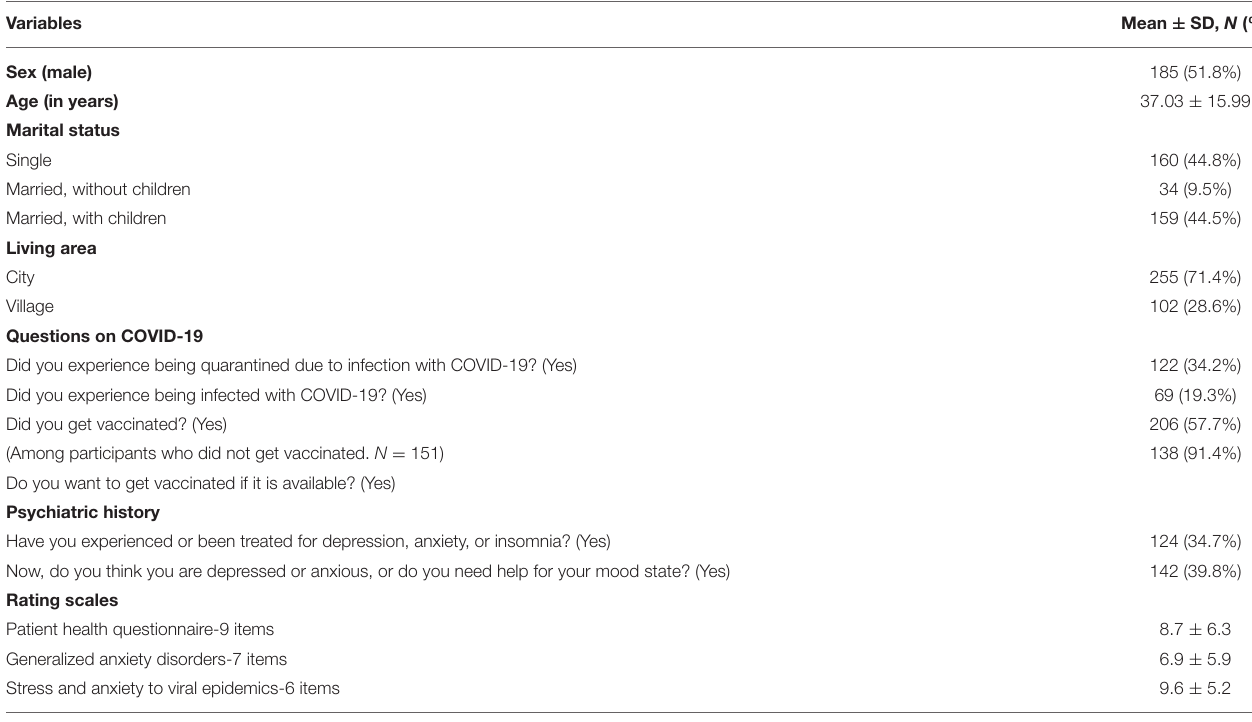
TABLE 1 | Clinical characteristics of the participants ( N = 357).